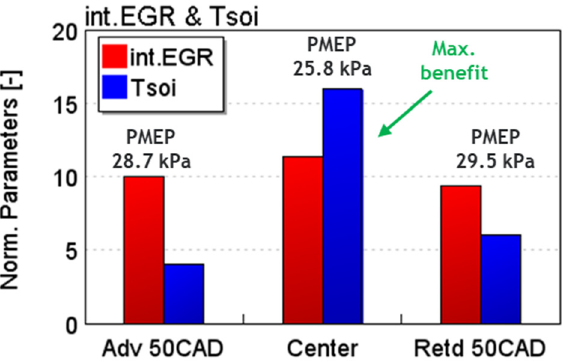
Figure 17. Comparison of Int.EGR and Tsoi trends among the three rebreathe locations for Tivc 404 K at B10. PMEPs are also identified for each location. at B10. PMEPs are also identified for each